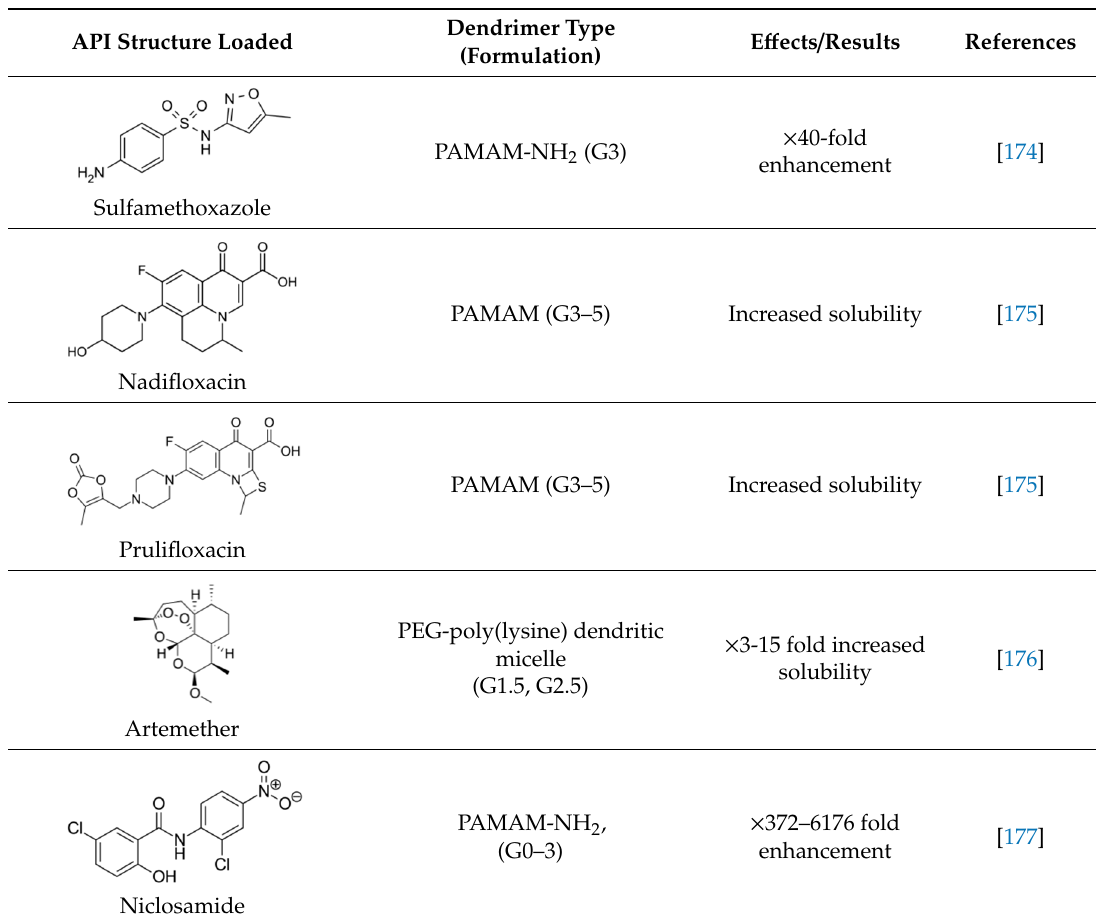
Table 6. Anti-microbial Drugs.